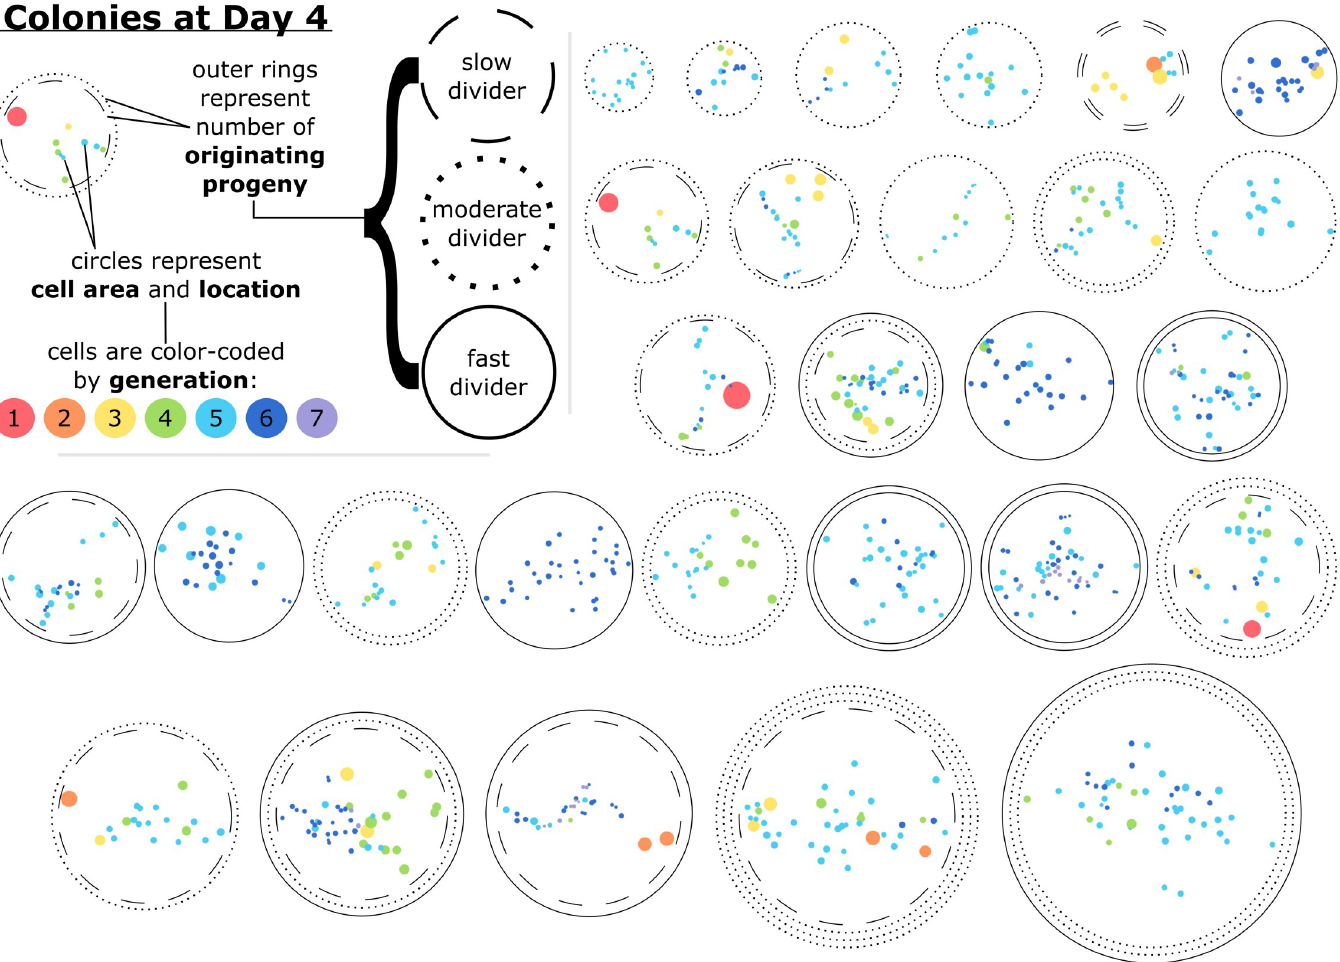
Fig 4. Cells within a colony after four days of growth varied by their size, generation, proximity to other cells, and the proliferative capacity of the progeny they belonged to. Glyphs representative of each colony studied at the single-cell level at Day 4 are presented. Cells are represented by filled circles, which are color-coded by generation and oriented based on the coordinates of the final time point of the single-cell time lapse image analysis. Similarly, the spread area of each cell is represented by the size of the color-filled circles. The outer rings of each colony represent the number and proliferative capacity of the originating progeny; slow dividers had less than three population doublings and fast dividers had more than four population doublings by Day 4. The example provided in the upper-left-hand corner is a representation of a colony after four days of development that originated from two cells, one of which proliferated slowly and one that proliferated moderately. This example colony had 10 cells at Day 4 ranging from first to fifth generation, with the first generation cell being relatively isolated and having a large spread area. The colonies are ordered horizontally by their approximate